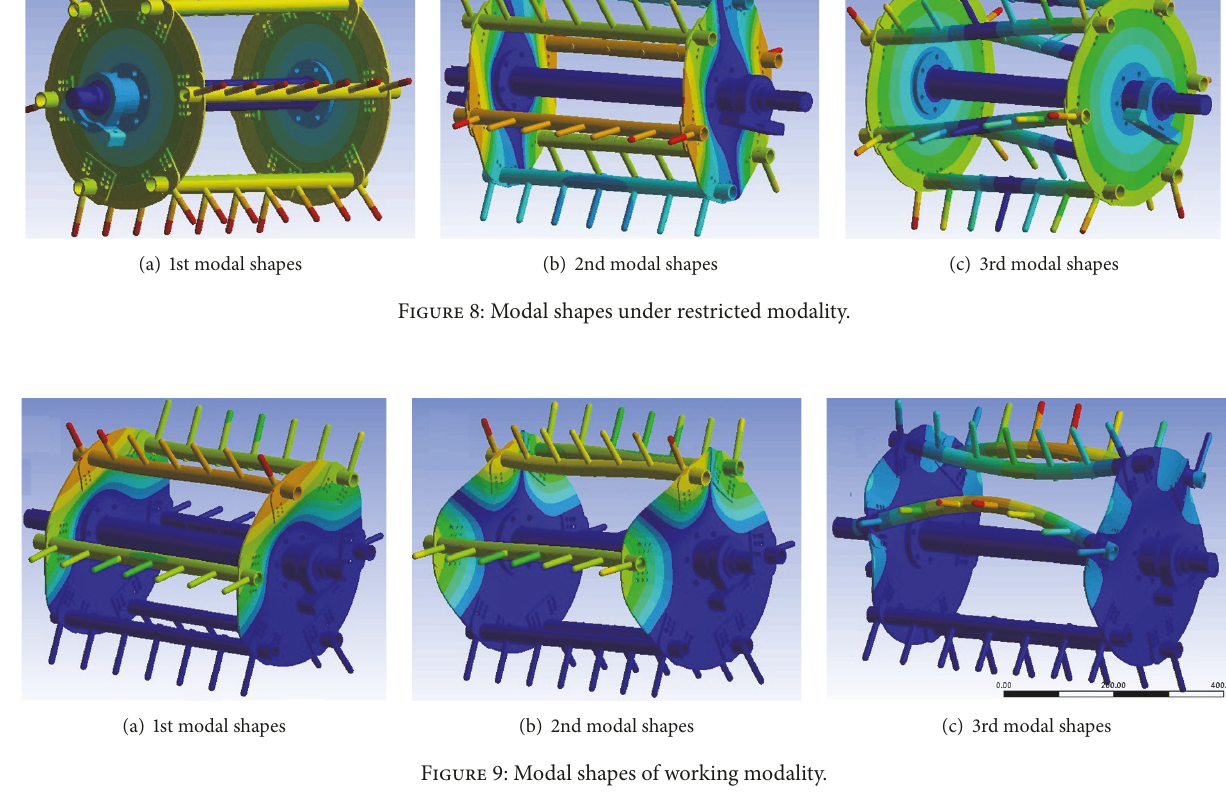
Figure 9: Modal shapes of working